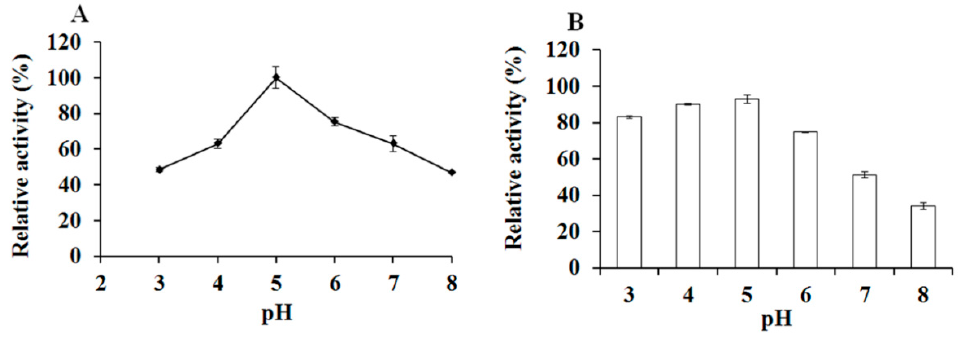
Figure 4. Effect of pH on the optiXynB activity ( A ) and its pH stability ( B ). The maximum value was set as 100 %.